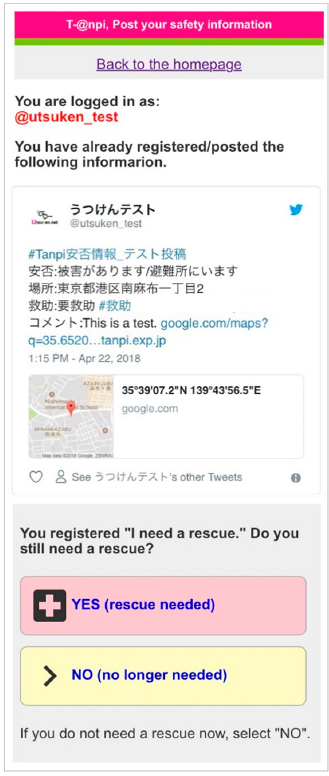
Figure 7. Page for confirming whether a sending user who previously requested a rescue still needs the rescue.